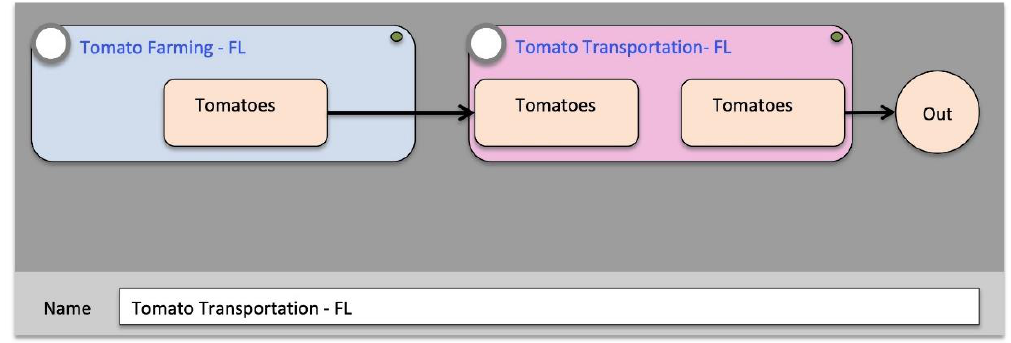
Figure 3. Florida raised tomato process for comparing CO 2 ( e ) emissions from farm to dining